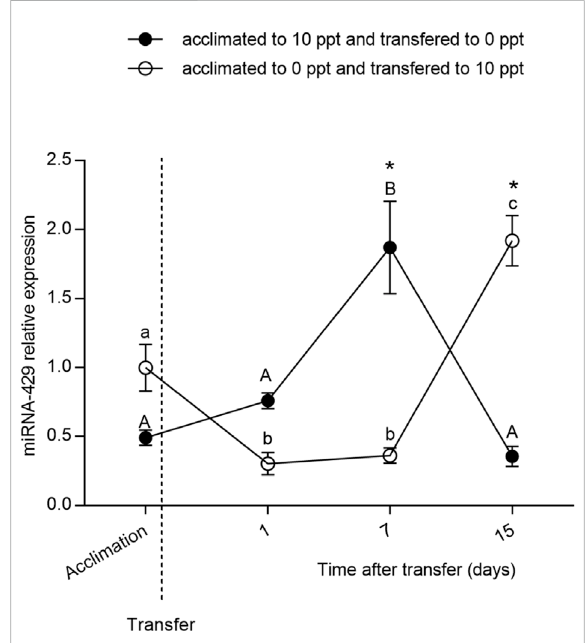
FIGURE 2 Relative expression of miR-429 from Odontesthes humensis submitted to salinity transfer. Different letters in each group (lowercase for freshwater (FW) to brackish water (BW) transferred group and uppercase for BW – FW transferred group) represent signi fi cant differences between the measurements in the same group. The asterisk ( p ) represents the signi fi cant difference between groups in a same experimental time ( p p < 0.05).TheverticalbrokenlineindicatesthetransferfromBWtoFW and from FW to BW